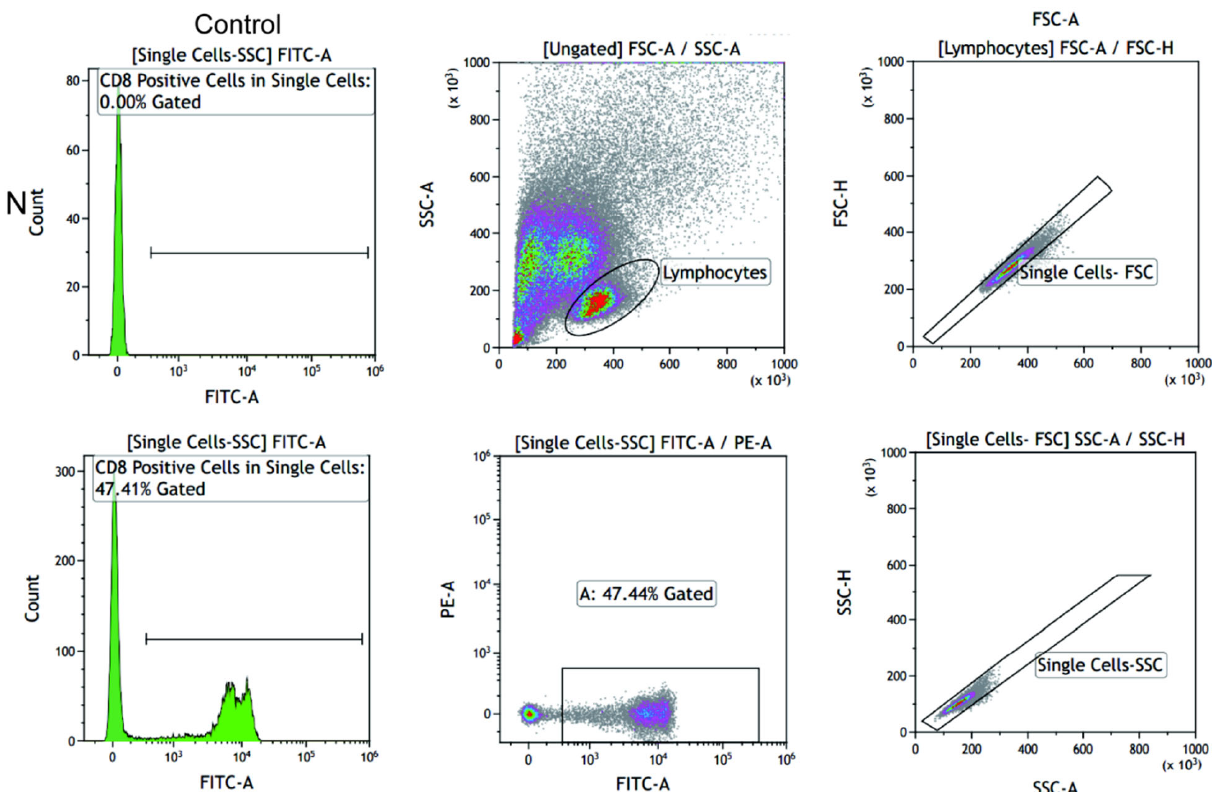
Figure 7. ( A ) CD8 + T cells were assayed by flow cytometric analysis between Groups N and C. MFI, Mean Fluorescence Intensity. * p < 0.05. ( B ) Western blotting expression of CD86, CD28, CD80 and CD40L between Groups N and C. ( C – F ) Quantitative comparison of CD86, CD28, CD80 and CD40L between Groups N and C. * p < 0.05.